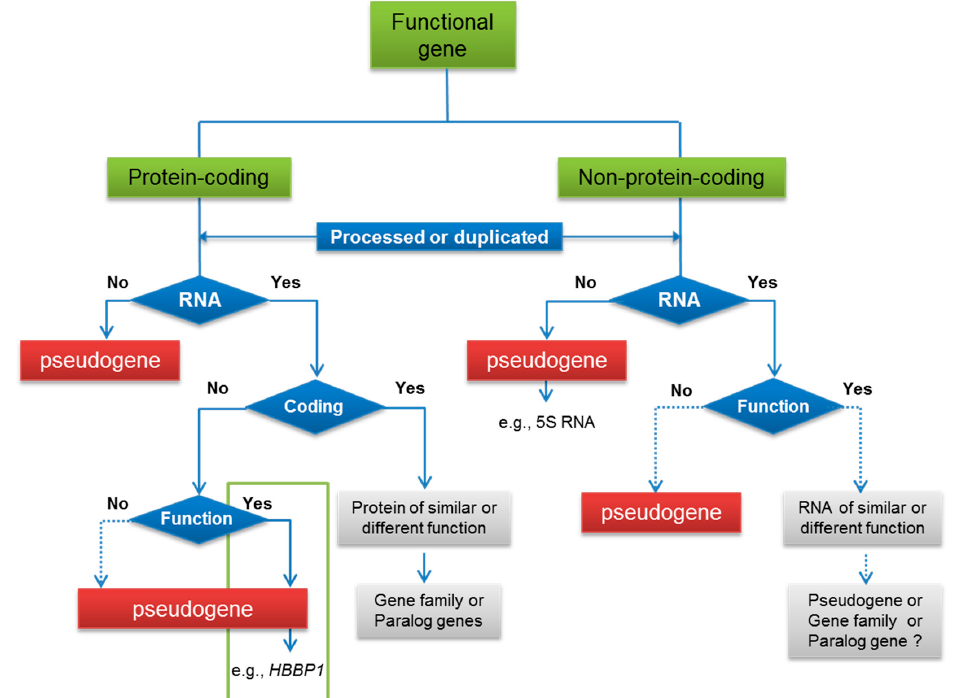
Figure 2. The emergence of processed or duplicated pseudogenes. Functional pseudogenes are indicated in the green framework. Solid arrows represent reference supports for the paths while dotted arrows show predicted paths. HBBP1 : Hemoglobin Subunit Beta Pseudogene 1 .